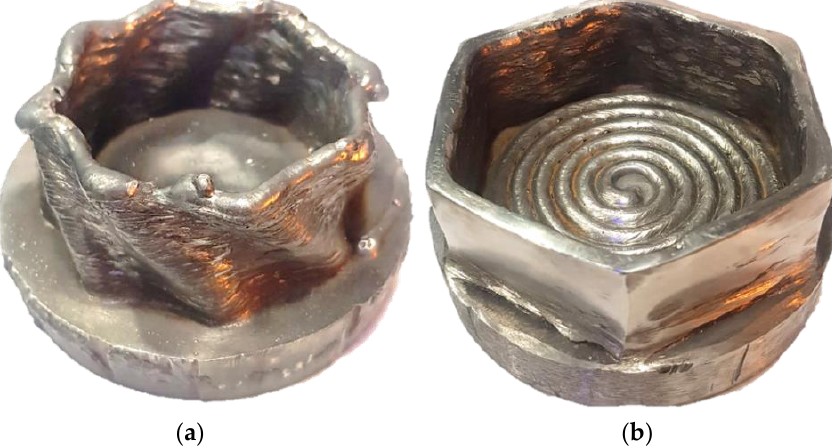
Figure 1. Picture of examples of WAAM-manufactured parts, “printed” by the authors. ( a ) depicts an unmachined parts, ( b ) shows an externally machined